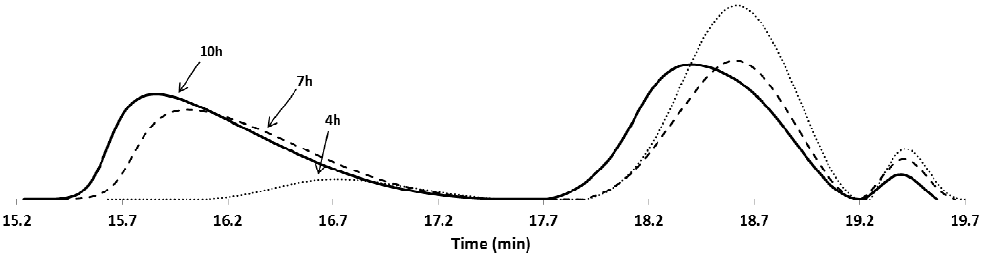
Figure 2. GPC traces from RI detector (entry 7 in Table 1) with the final polymer molecular weight of 10.2 kg/mol.